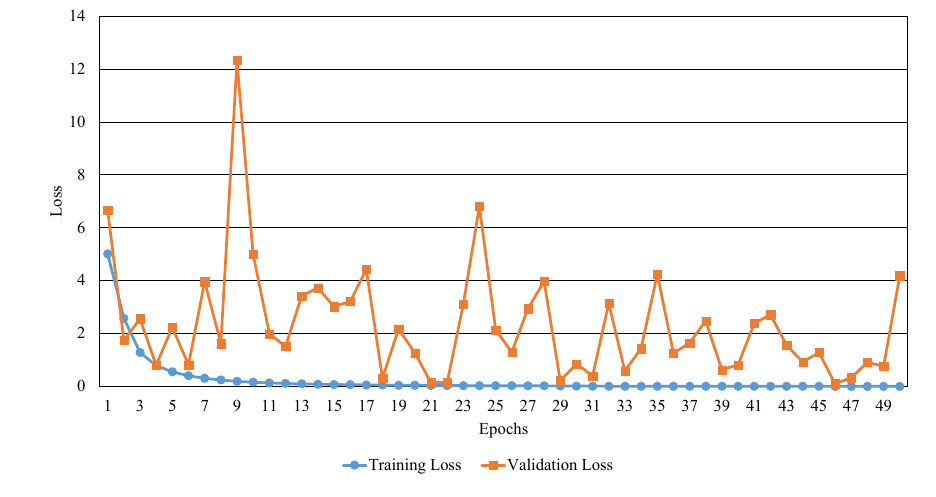
Figure 6. The results of training and validation losses over epochs.